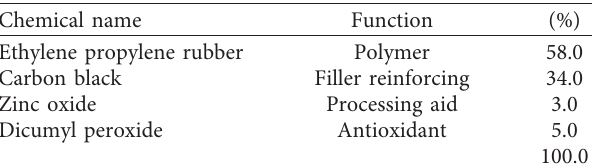
Table 2: The chemical composition of the EPDM rubber compound.